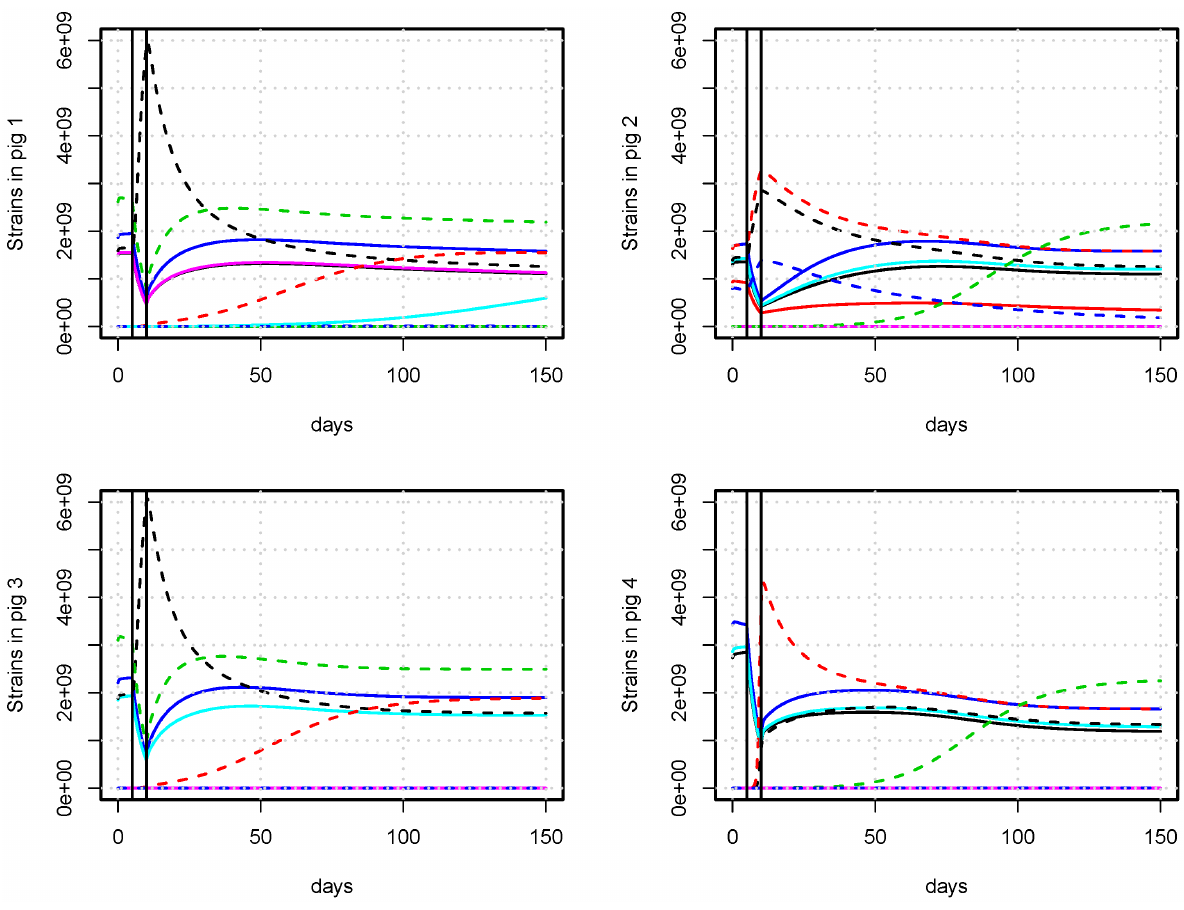
Figure 3. Bacterial composition of the gut of pigs treated with antimicrobials. An example of the count of strains in four pigs with AMT between day 5 and 10. Unique strains are identified by different colors. Resistant strains are identified with dashed lines. Antimicrobials are administered in the time between vertical black lines given as an effective concentration of 40 m g/mL in the intestinal tract, which is so high that some strains labeled resistant (i.e. the green) also experience a decline. Compared to figure 2 with no antimicrobial treatment, resistant strains spread throughout the population on a time-scale of days, and an increase in resistant bacteria for months following treatment (see also figure 6) can be observed. The strains used in figure 2 and 3 are identical, only the use of antimicrobials is different.